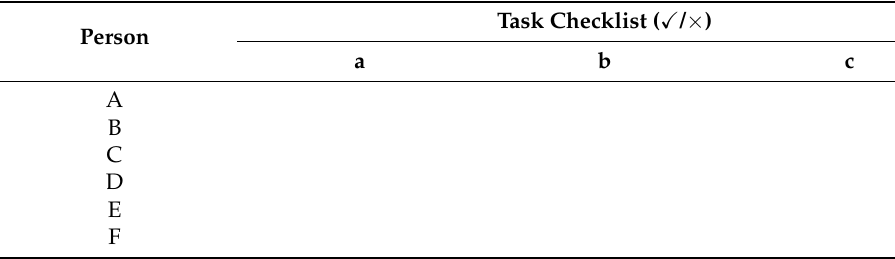
Table 13. Preparation of checklist for testing of the wheelchair